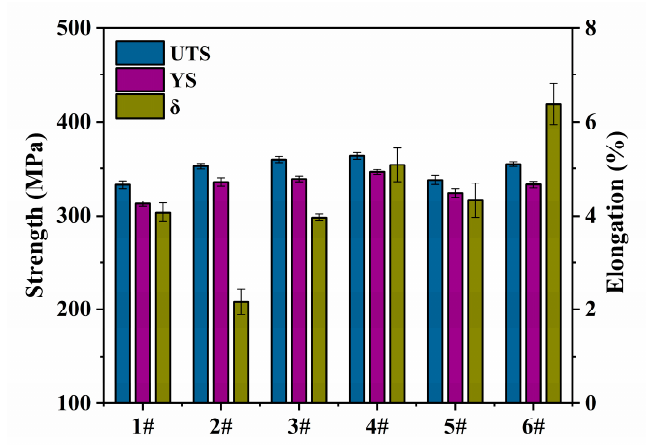
Figure 9. Stress-strain curves of alloys.